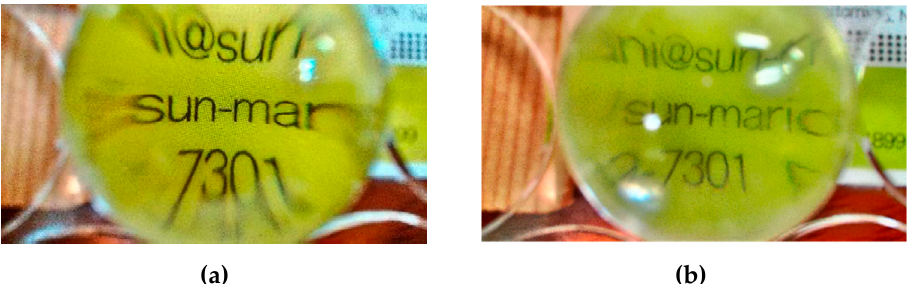
Figure 13. Comparative photographs of the prototype ( a ) homogenous spherical lens and ( b ) CSSP lens.